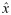
Cosmetic surgery.We modify gi(x) + δ from x^ to 0 such that the new function g˜i(x) has an infinite slope at x = 0. Similarly, we modify gi(x) + δ from xˇ onwards so that the slope of g˜i(x) is zero from Xi+ onwards.